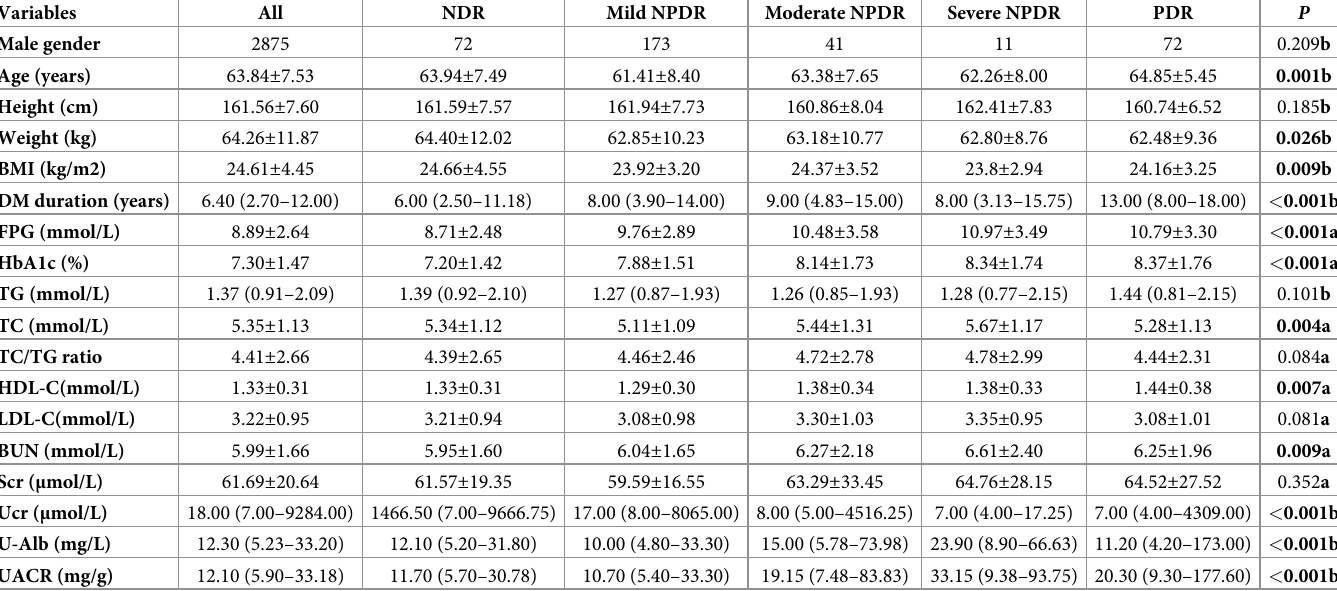
Table 2. Characteristics of study subjects by the presence of